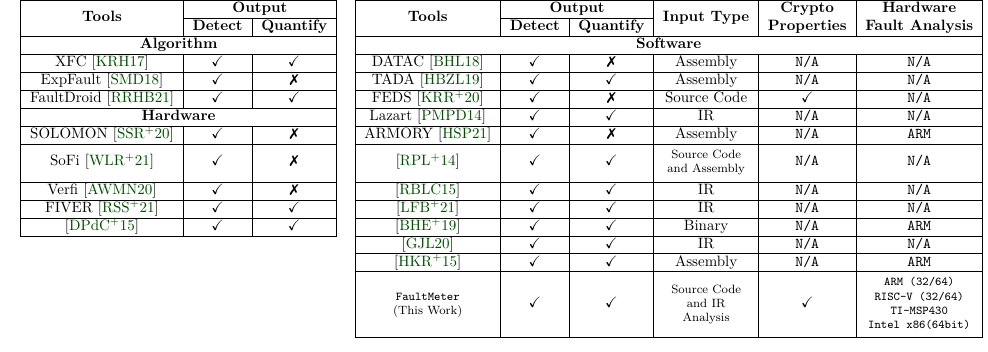
Table 1: Comparison with the state-of-the-art fault attack automation tools. FaultMeter is the only tool that works at the implementation level and considers the cryptographic properties, different hardware to quantify the